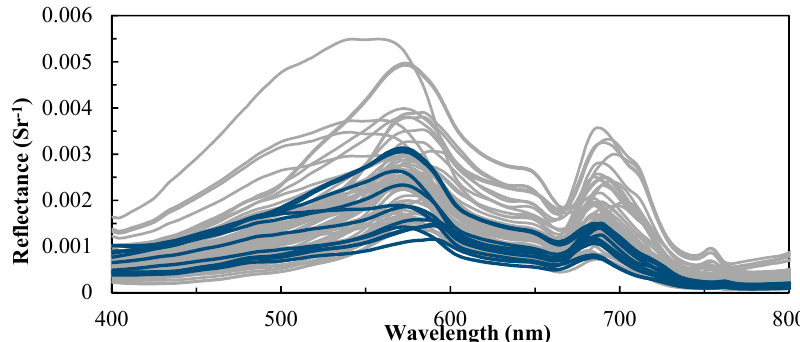
Figure 2. Remote sensing reflectance of 70 stations that were collected from Tokyo Bay. The gray lines denote stations with water quality parameters and remote sensing reflectance values. The blue lines represent the 12 stations with additional measurements for the inherent optical properties.